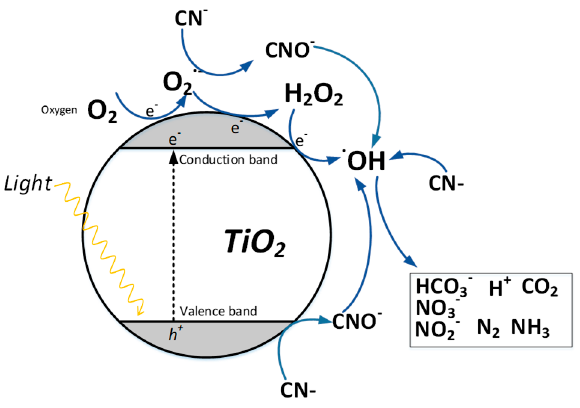
Figure 3. Photocatalytic scheme of free cyanide in a TiO 2 particle. Adapted from Reference [21].